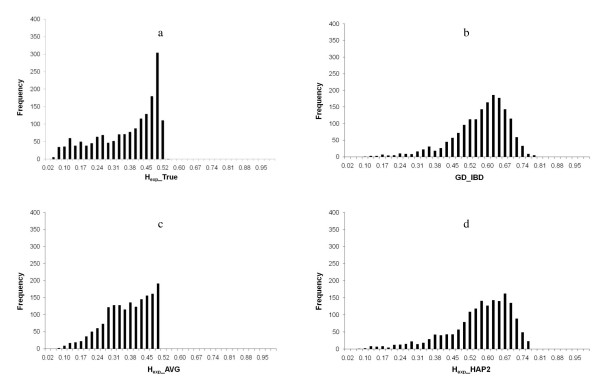
a, b, c, d - Frequency of the estimated genetic diversity across the simulated genome. (a) True genetic diversity calculated by expected heterozygosity for the ungenotyped marker loci within the marker interval (Hexp_TRUE); (b) Estimated genetic diversity with IBD probabilities between marker haplotypes (GD_IBD); (c) Estimated genetic diversity with expected heterozygosity as an average for the two flanking markers (Hexp_AVG); (d) Estimated genetic diversity with expected heterozygosity for the two flanking markers as a two marker haplotype (Hexp_HAP2).